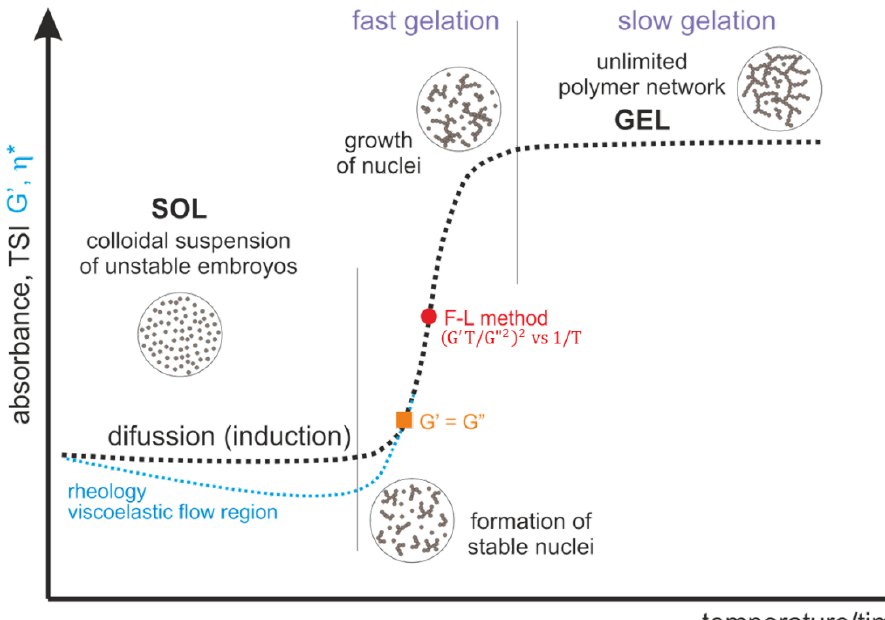
Figure 13. Characteristic parameters course during the sol-gel phase transition of colloidal chitosan systems, taking into account the formation of stable nuclei and their further aggregation.